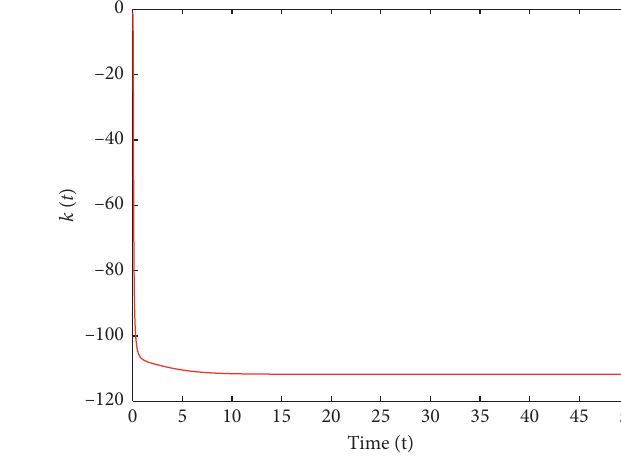
Figure 3: k ( t ) approaches to